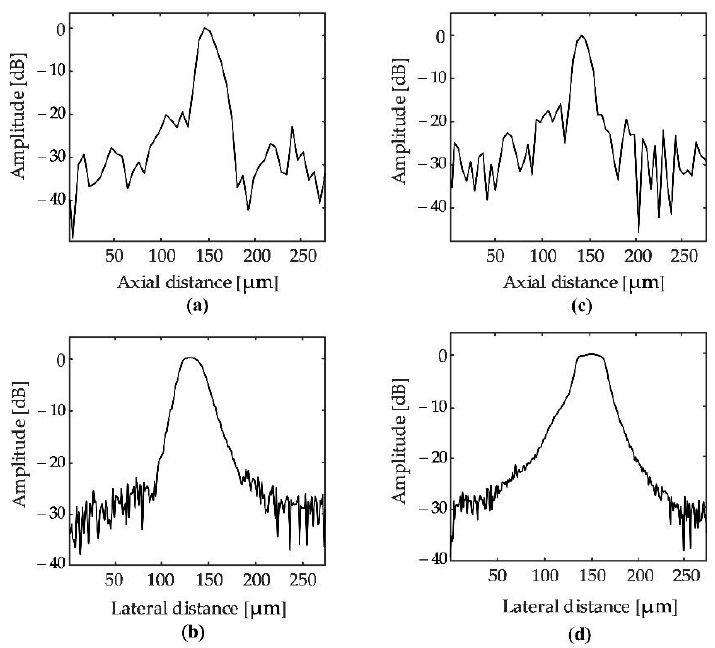
Figure 6. ( a , b ) Measured axial and lateral resolution of the PMN-0.3PT transducer. ( c , d ) Measured axial and lateral resolution of the LiNbO 3 transducer.